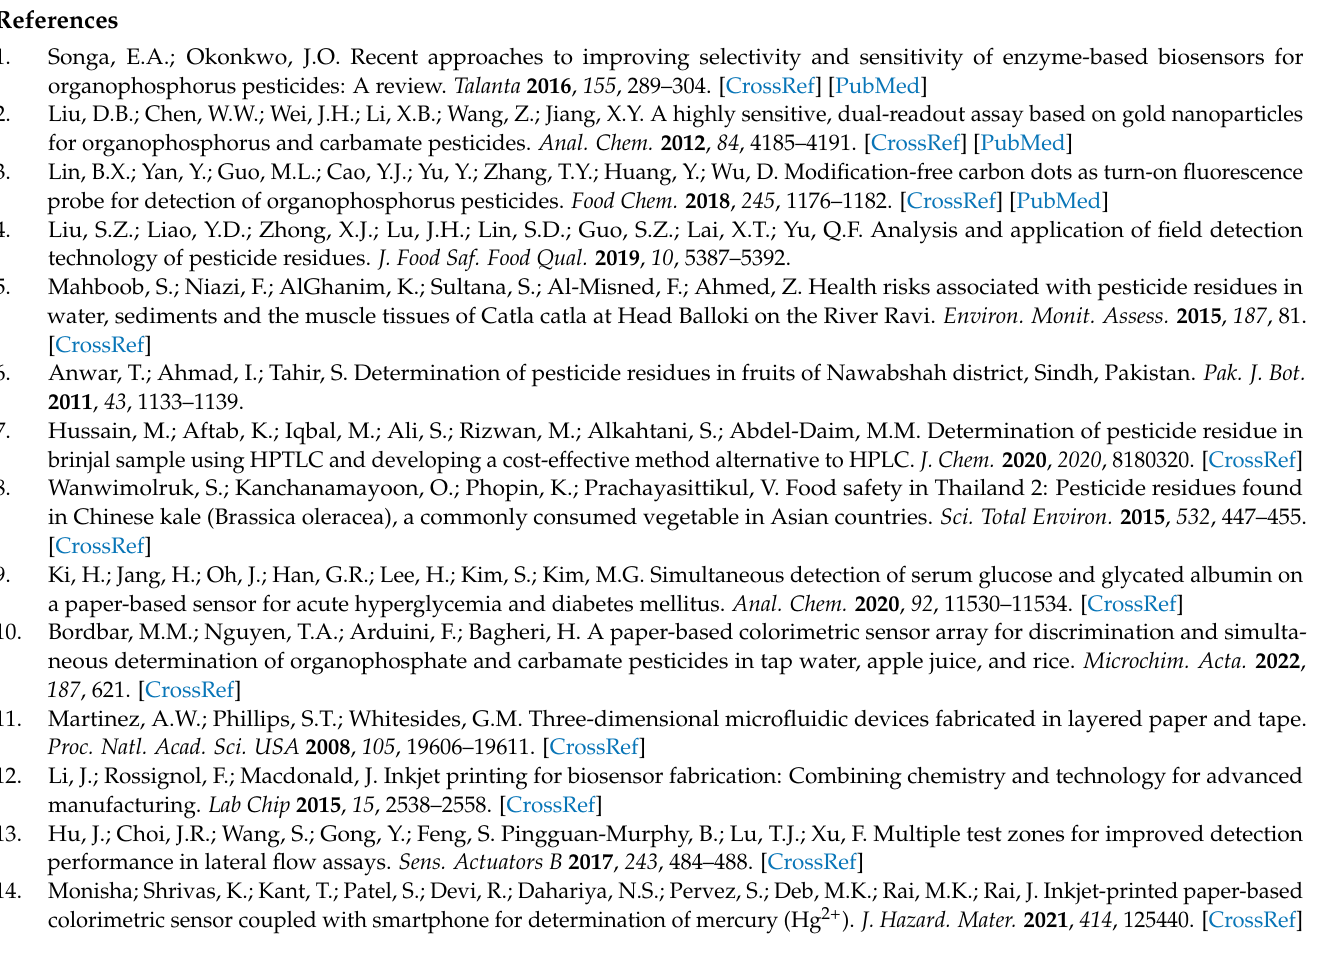
Figure S3: The effect of time for the detection of chlorpyrifos by pSBMA- µ PAD; Figure S4: The effect of time for the detection of profenofos by pSBMA- µ PAD; Figure S5: The effect of time for the detection of cypermethrin by pSBMA- µ PAD; Table S1: Relative compositions of bare-CF